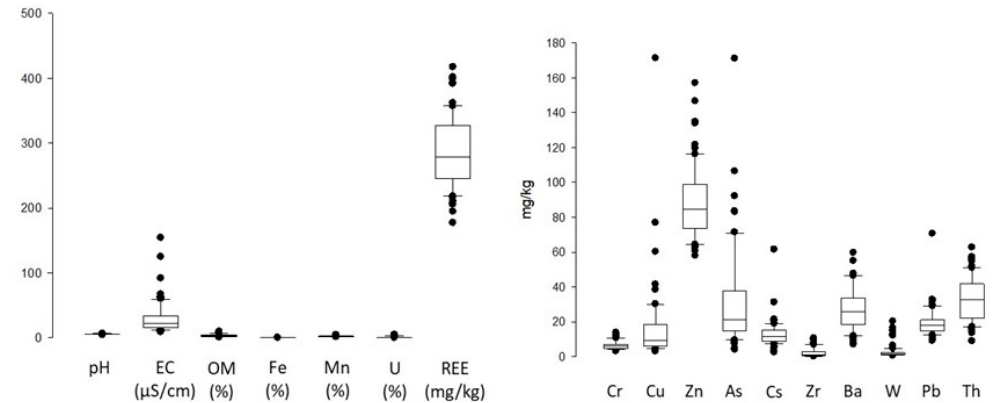
Figure 2. Box plots for physicochemical parameters, trace elements, and REE concentrations in stream sediments, soils, and mine dumps from Canto Lagar region. The symbol ● represents values of minimum (lower end), maximum (upper end) and outlier (intermediate) concentrations.